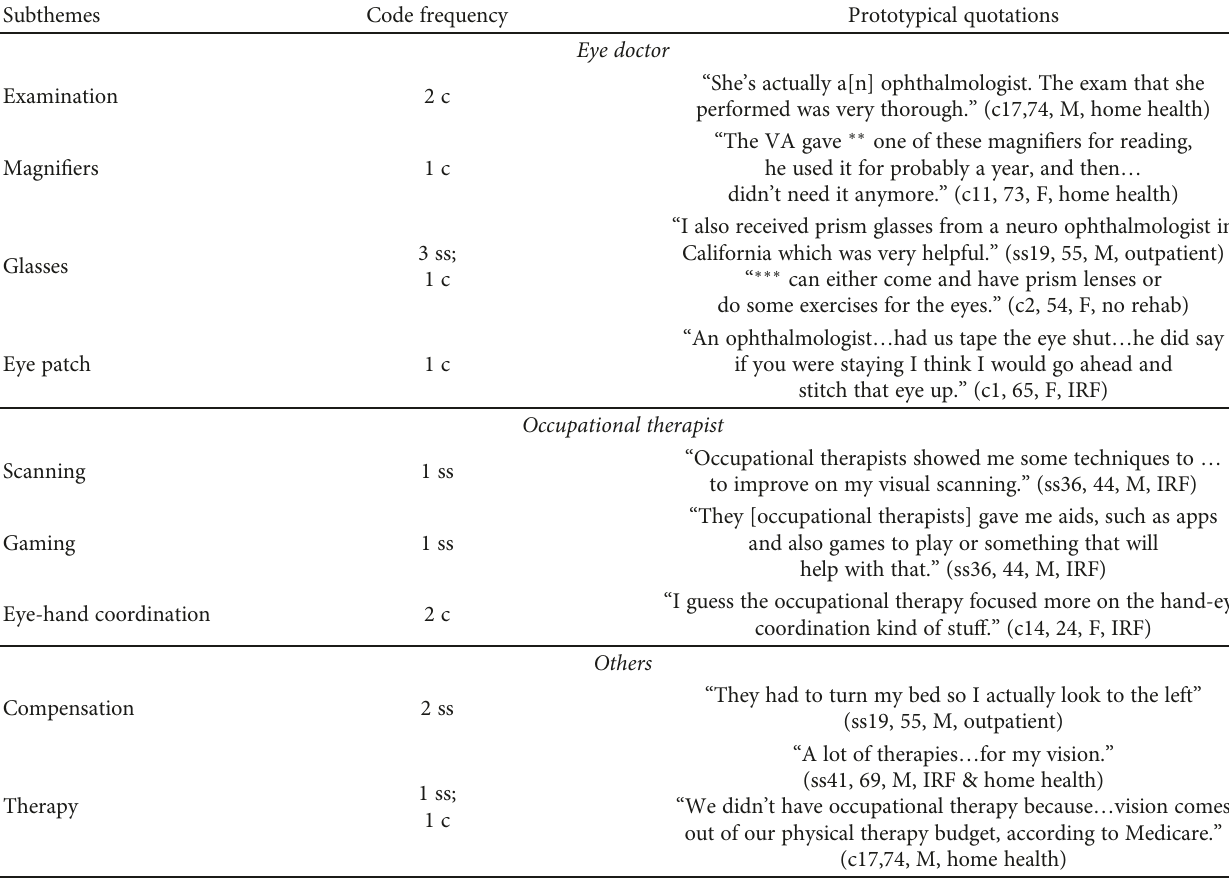
Table 2: Subthemes and codes for the theme: vision care